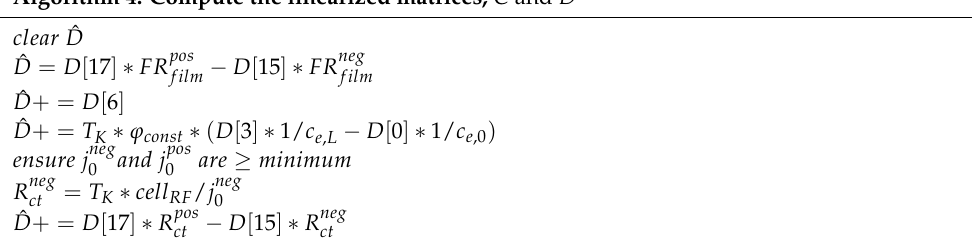
Algorithm 4: Compute the linearized matrices, ˆ C and ˆ